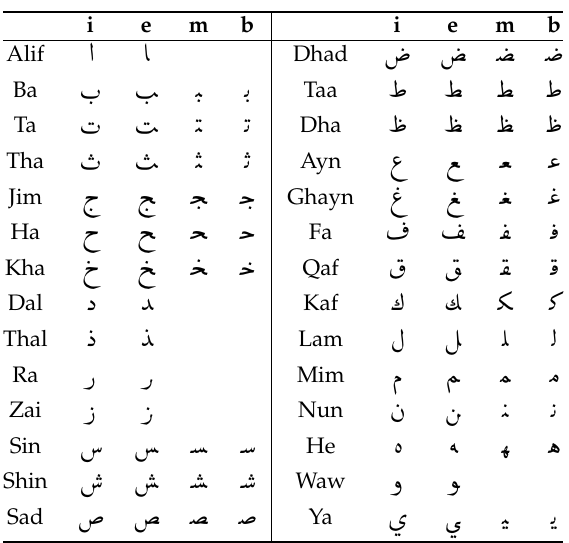
Table 1. Arabic Alphabet, Naskh